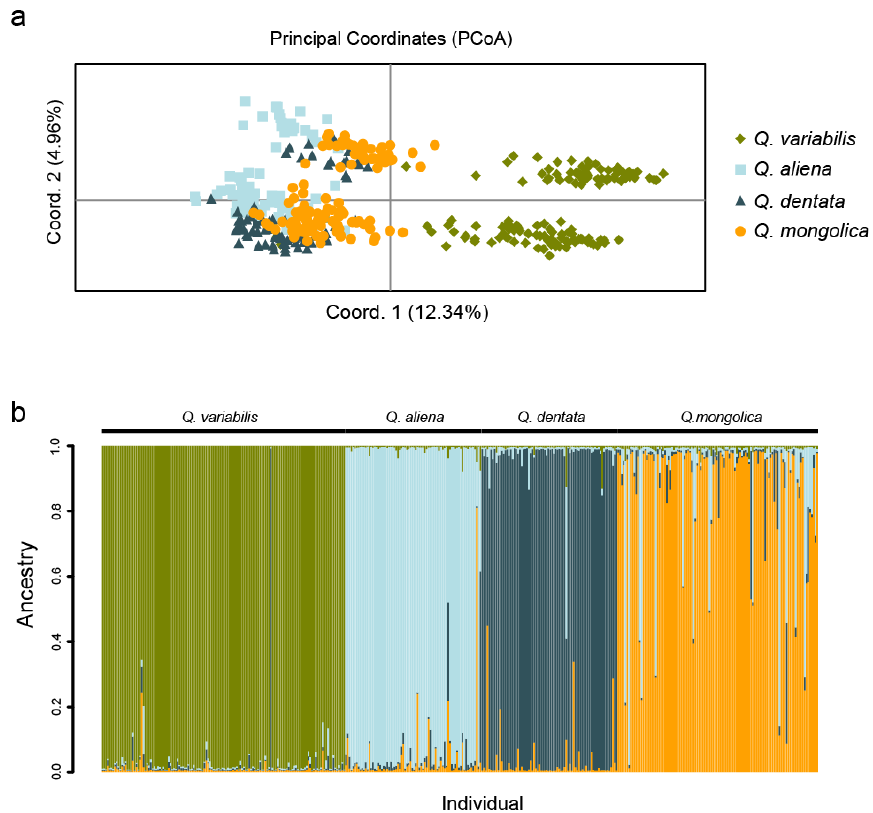
Figure 2. PCoA and population structure for all the 400 individuals. ( a ) PCoA groups of four oak species are calculated and plotted by GenAlEx6.5. Different colors indicate different species, and each point represents an individual. ( b ) Population structure based on Bayesian clustering approaches with K = 4 by STRUCTURE software. Each bar represents a single individual and different colors indicate different subpopulations. The individual species are shown at the top of the bars. The regions where we collected samples are located on the edge of the North China Plain (Figure 3), and they are near the borders of natural distribution of Q. mongolica and Q. aliena (Supplementary Figures S1 and S6). The pie charts indicated a proportion of gene pools distributed in 10 oaks populations, of which Q. mongolica is the most